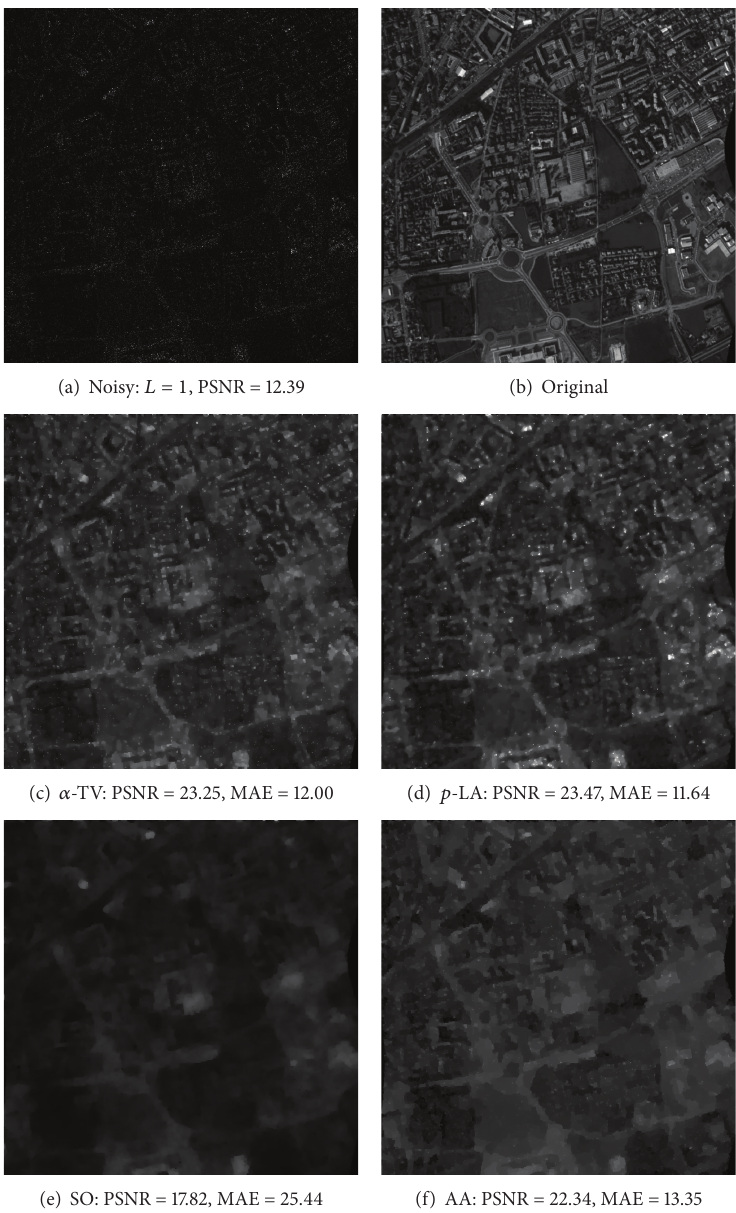
Figure 5: Aerial image ( 512 × 512 ). (a) Noisy image corrupted by speckle noise for 𝐿 = 1 in (8). (b) Original image. (c) Our algorithm by = 1.4 . (e) SO algorithm, 𝜆 = 0.1 , 𝛼 = 0.25 . (f) AA algorithm, 𝜆 = 25 𝛼 -TV, 𝜎 = 2 , 𝑘 = 0.03 , and 𝜏 = 0.05 . (d) Our algorithm by 𝑝 -LA, 𝑝 𝑈